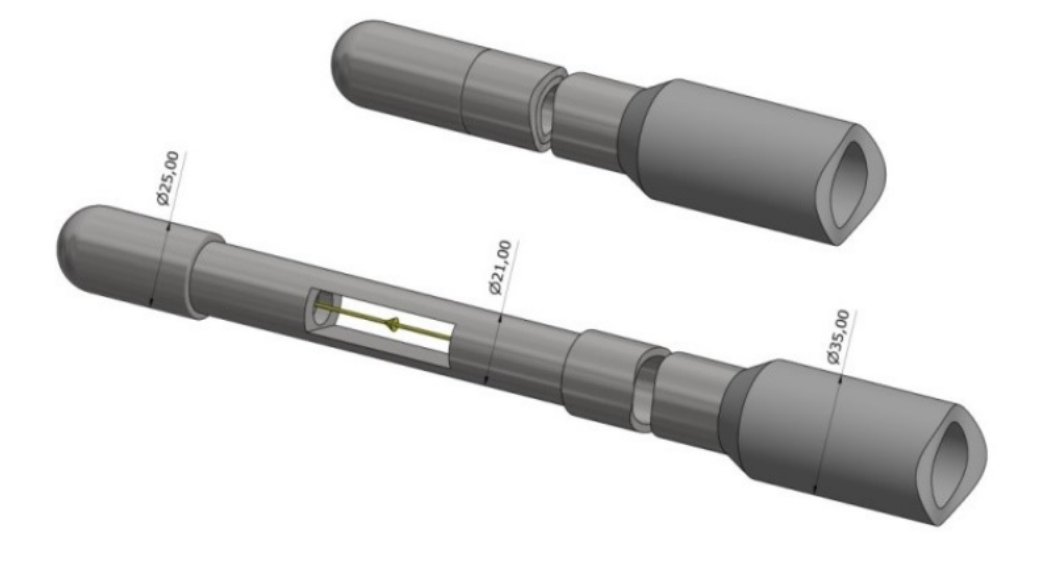
Figure 3. Optical probe head with open and closed measuring space.